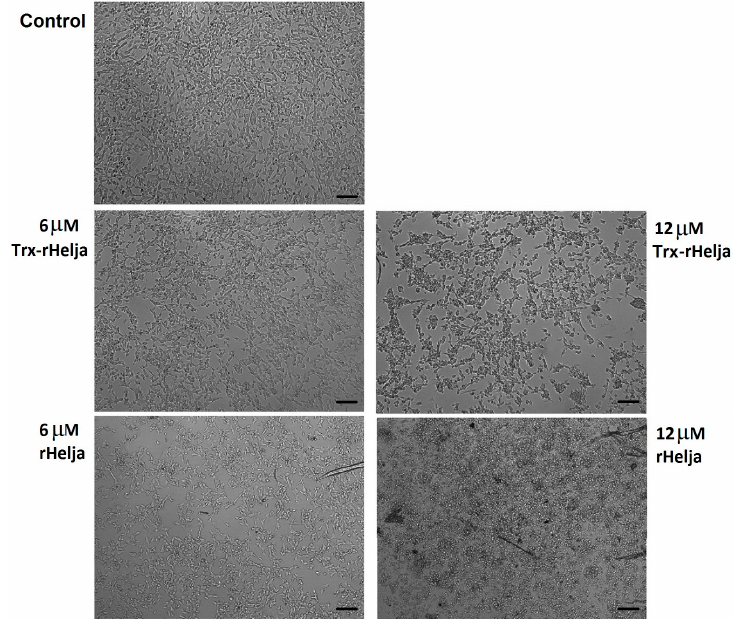
Figure 5. Cell morphology changes in human neuroblastoma SH-SY5Y cells treated with Trx-rHelja or rHelja. The cells at density of 5 × 10 4 cell/well were grown for 24 h before the incubation with 6 and 12 μ M Trx-rHelja or rHelja for additional 24 h. Cells were examined using a phase contrast microscopy (10× lens). Scale bar = 10 μ m.